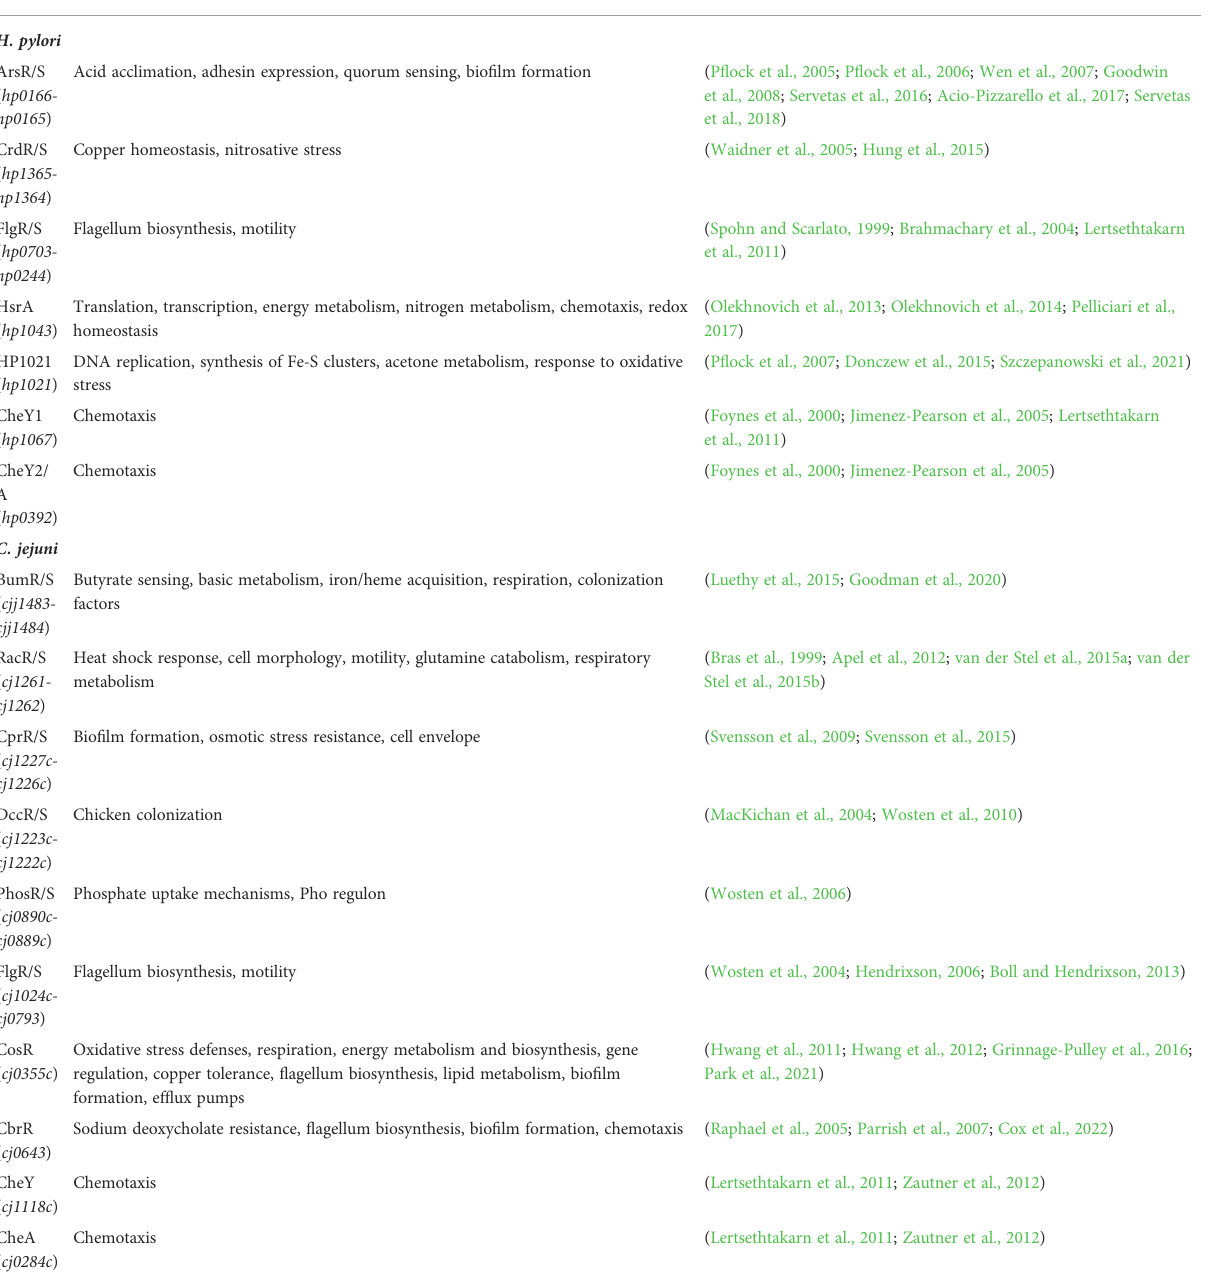
TABLE 1 TCRS expressed by H. pylori and C. jejuni